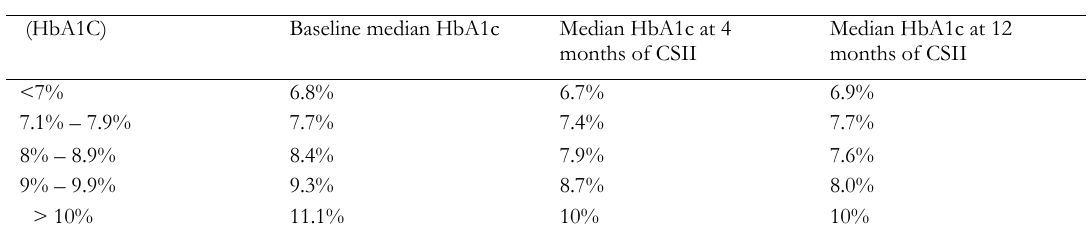
Table 3: Reduction in median HbA1c after CSII